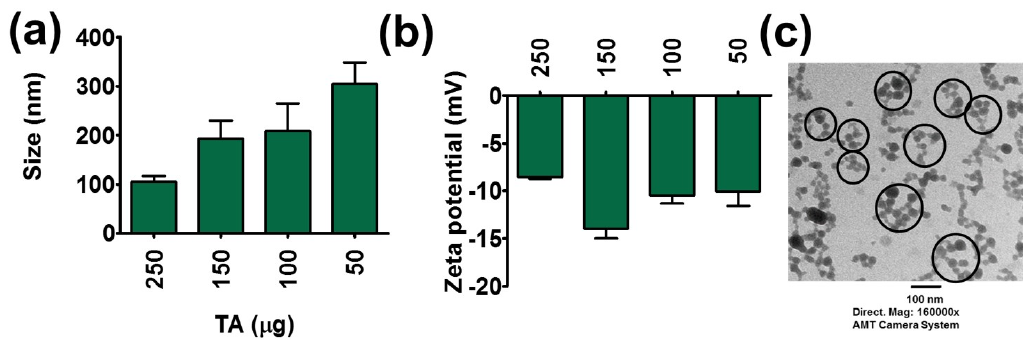
Figure 2. Physical characterization of TA-LF complexes. ( a ) Particle size and ( b ) zeta potential of TA-LF complexes. Measurements were performed using Zetasizer. Increasing LF inclusion in TA-LF alters protein corona on TA and the change in their particle size and zeta potentials. Data presented as mean ± SEM ( n = 3). ( c ) Representative transmission electron microscopic image of TA-LF self-assemblies. Image was acquired using advanced microscopy digital camera system Print magnification 160,000 ×